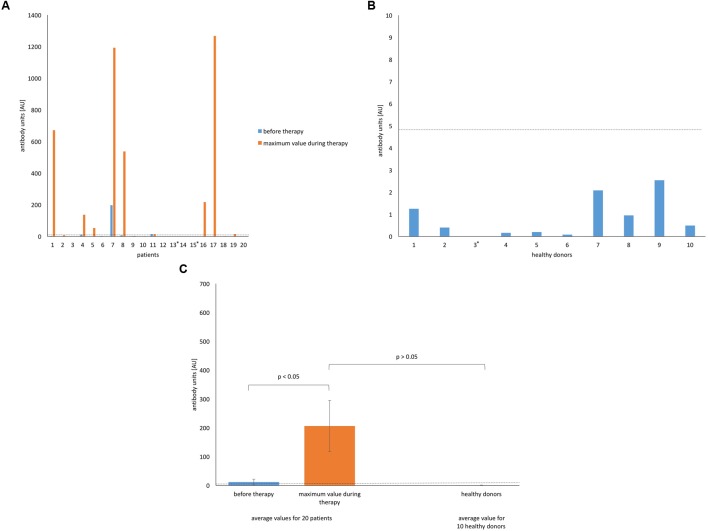
The levels of IgM anti-MS-1 phage antibodies in human sera. (A) Patients (n = 20) treated with S. aureus MS-1 phage cocktail. (B) Healthy (n = 10) donors. An asterisk next to the number of a healthy donor means an undetectable level of antiphage antibodies. (C) Average values for patients treated with S. aureus MS-1 phage cocktail and healthy donors. Average values are plotted with the SE indicated by the error bars. Median value for the group of patients during treatment is marked on each graph by a horizontal dotted line.